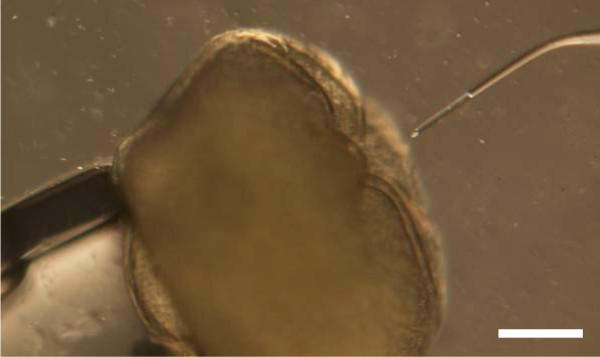
Nuclear transfer through the micropyle of non activated oocytes. The micropyle is seen as a large circular hole with hills and valley-shaped rim. Scale bar = 500 μm.